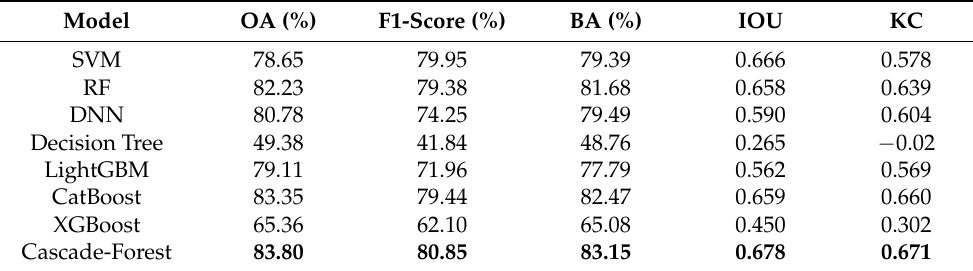
Table 7. Evaluation of the generalization of different FSM models for the second scenario. Support Vector Machine (SVM), Random Forest (RF), Deep Neural Network (DNN), Decision Tree (DT), Light Gradient Boosting Machine (LightGBM), Categorical Boosting (CatBoost), Extreme Gradient Boosting (XGBoost), and Cascade Forest Model (CFM). OA: overall accuracy; IOU: intersection over union, BA: balance accuracy; KC: kappa coefficient. The highest value is in bold.